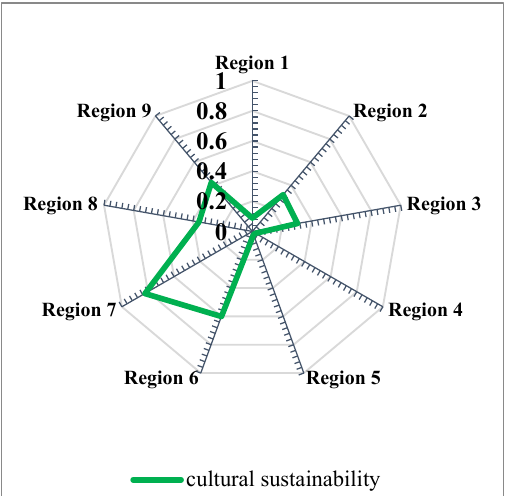
Figure 11. Barometer of s ustainability.